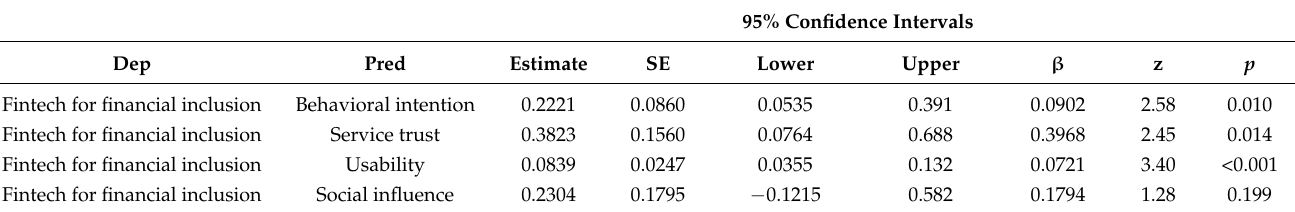
Table 4. Parameter